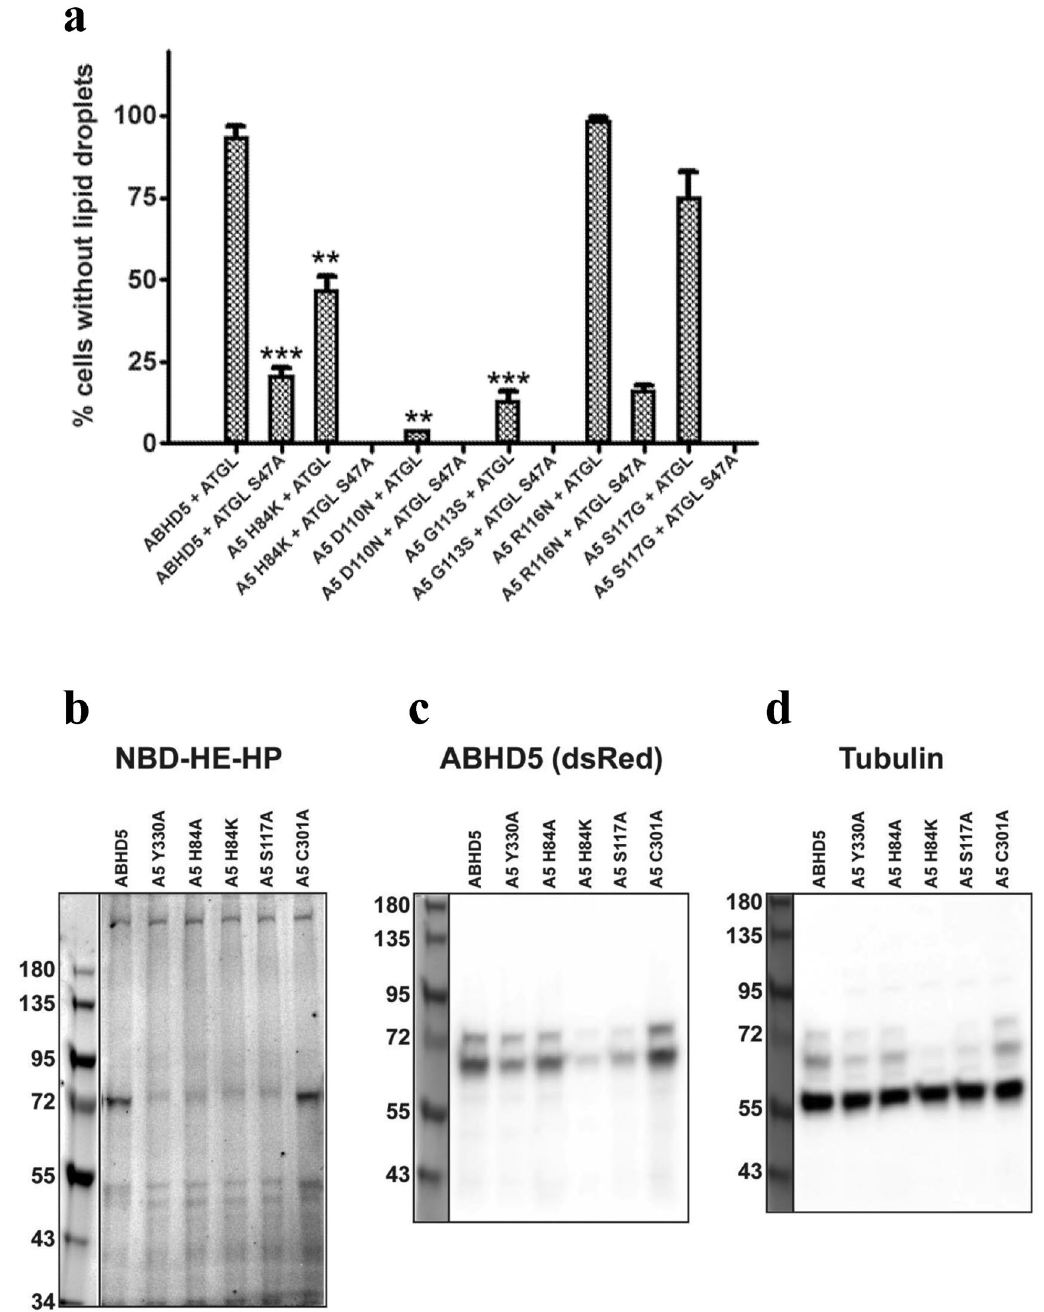
Figure 6. Lipid droplet formation and NBD-HE-HP affinity probe labeling in transfected Cos7 cells. ( a ) Cos7 cells transfected as described in “Methods and data” were lipid loaded and scored for the presence of lipid droplets by blinded analysis. Only cells visibly expressing all three transfected proteins (ABHD5 or ABHD5 mutant-mCherry, Plin1-EYFP, and ATGL or ATGL S47A-ECFP) were scored. Results are mean ± SEM from three independent experiments. **p < 0.01 compared to wild-type ABHD5/ATGL; ***p < 0.001 compared to wild-type ABHD5/ATGL. ( b ) Cos7 cells transfected with cherry-tagged ABHD5 or ABHD5 mutants were labeled with the affinity probe NBD-HE-HP (50 µM) then labeled proteins were resolved by SDS-PAGE and imaged as described in “Methods and data”. The gel was then immediately transferred to a PVDF membrane and cherry-tagged proteins were detected with dsRed antibody ( c ), then immunoblot was reprobed with α/β-tubulin antibody ( d ). One of two independent experiments with similar results is